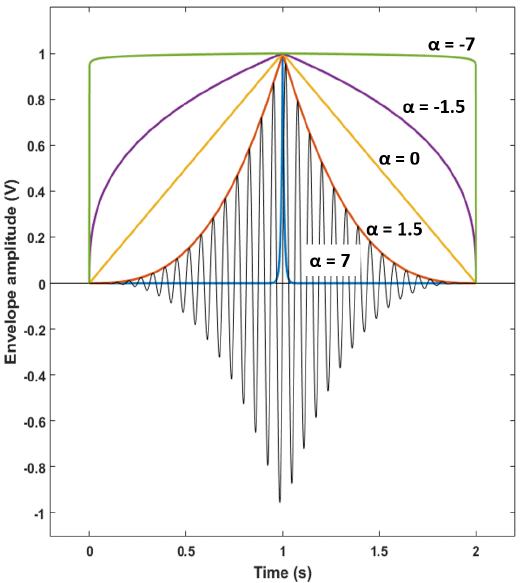
Figure 1. Illustrating how the stimuli in block 2 of Experiment 1 were created. The amplitude represents the displacement of the tactile actuator element used in Experiment 1 to produce precise sensations at a single location on the fingertip. Envelope functions (described by y = ( t − c ) 2 α ) are shown for alpha = {− 7, − 1.5,0,1.5,7 } . Increasing and decreasing parts of the envelope function are concatenated to create a set of entire envelopes. Final waveform demonstrated with a 12 Hz sine wave for α =